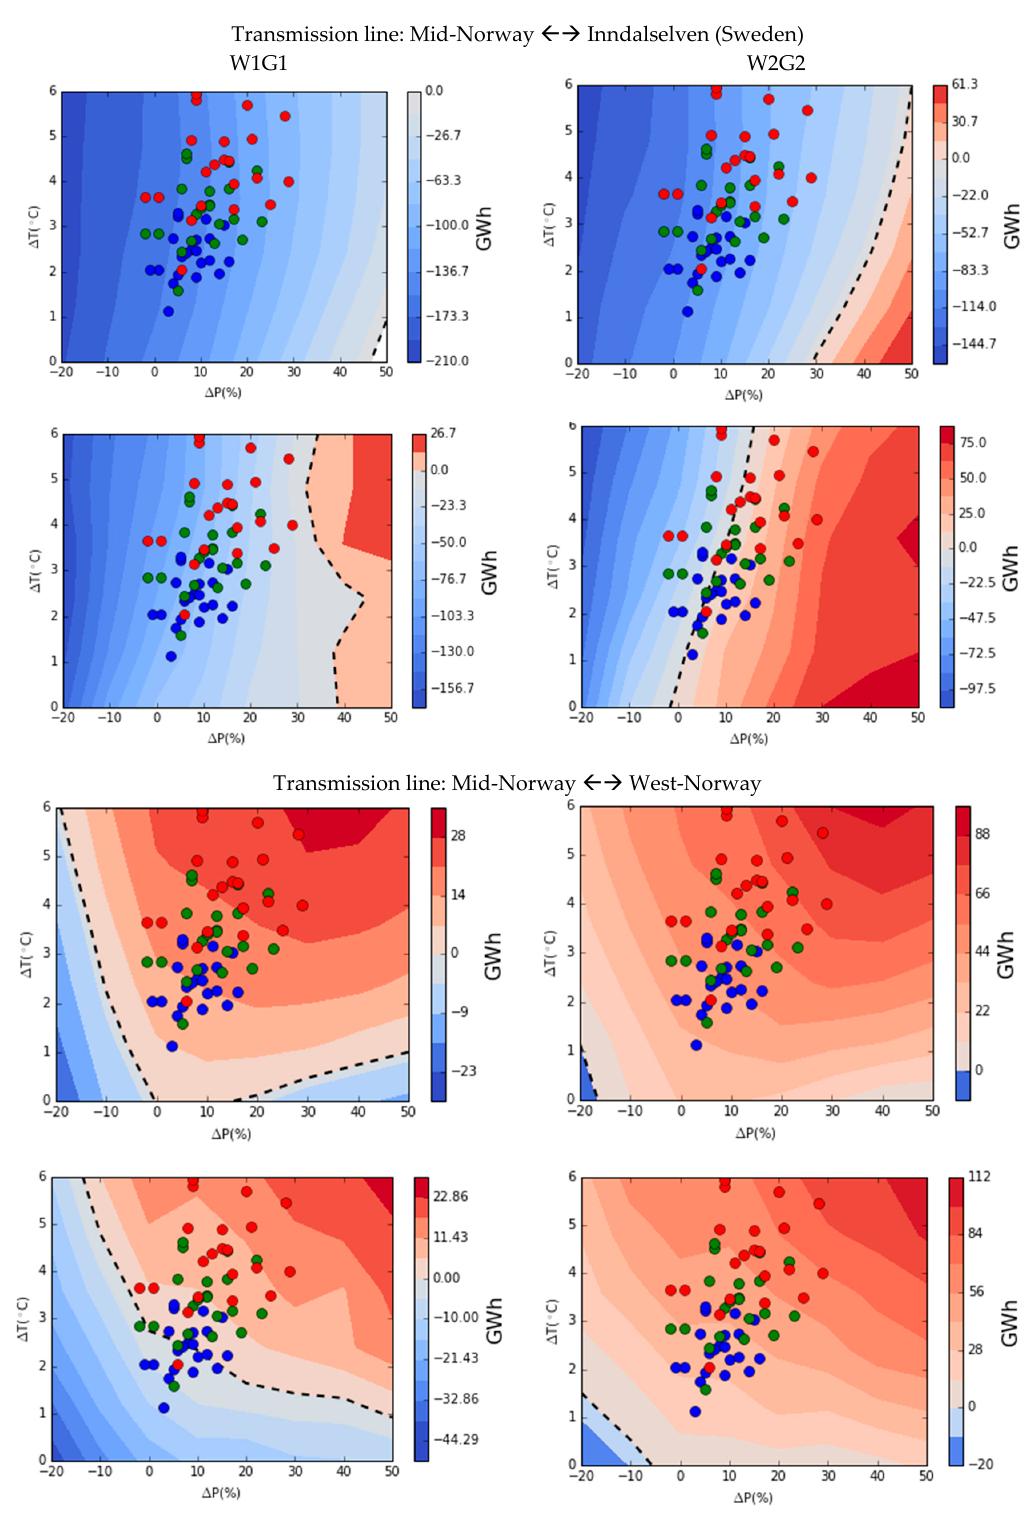
Figure 7. CRFs of the Mid-Norway energy exchanges with: Inndalselven (Sweden) ( top ); and West-Norway ( bottom ). CRFs left and right columns are obtained with W1G1 and W2G2 scenarios respectively. For each transmission line, top CRFs are for the whole year and the bottom for the winter season. Nil energy balance curves are highlighted with dashed black lines. For more details, see Figure 6 caption.